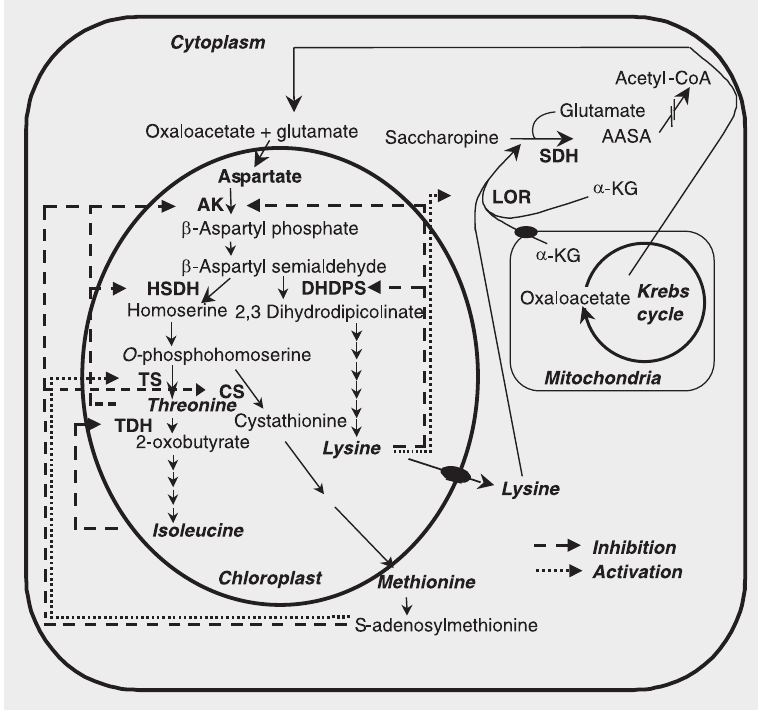
Figure 2. The aspartate metabolic pathway of higher plants. AK = aspartate kinase; HSDH = homoserine dehydrogenase; DHDPS = dihydrodipicolinate synthase; TS = threonine syn- thase; CS = cystathionine- γ -synthase; TDH = threonine dehydratase; LOR = lysine-2- oxoglutarate reductase; SDH = saccharopine dehydrogenase; AASA = α -aminoadipic acid; α -KG = α